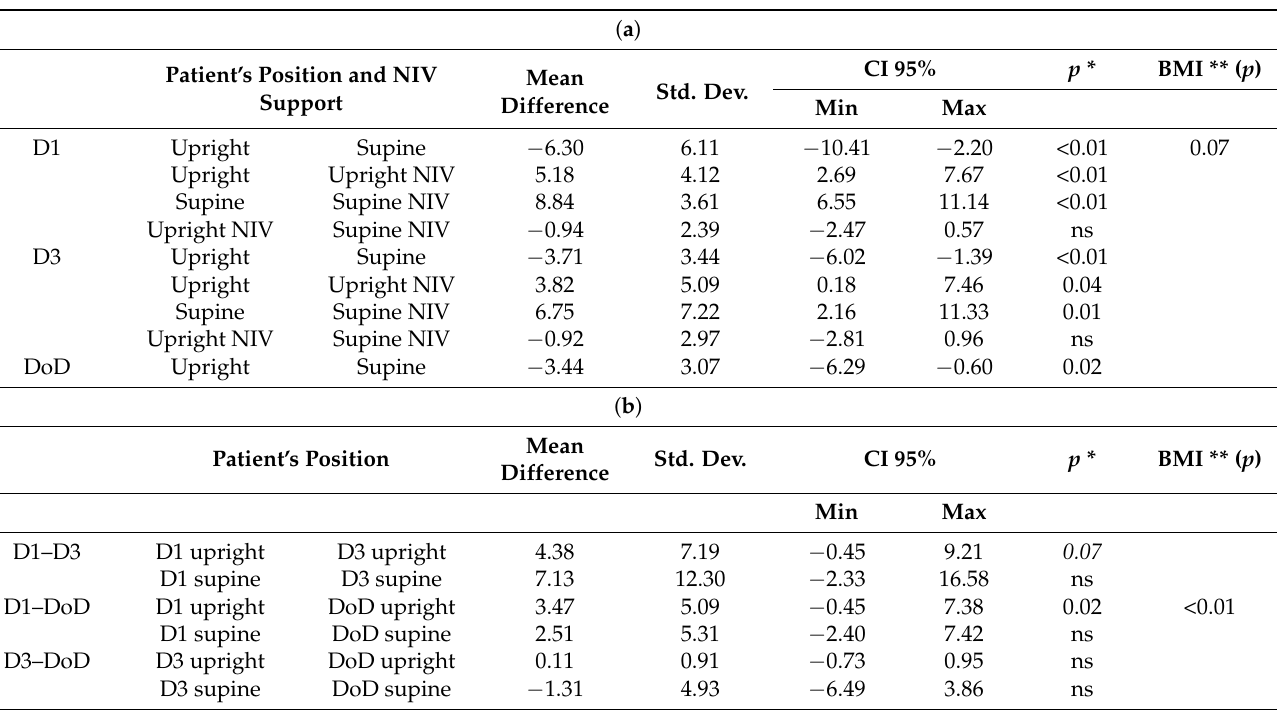
Table 3. ( a ) The intraday variation of mean ∆ Pes (i.e., the mean difference of ∆ Pes) relative to the position and the presence of NIV support and its relationship with BMI. ( b ) The interday variation of mean ∆ Pes (i.e., the mean difference of ∆ Pes) relative to the position and its relationship with BMI in the absence of